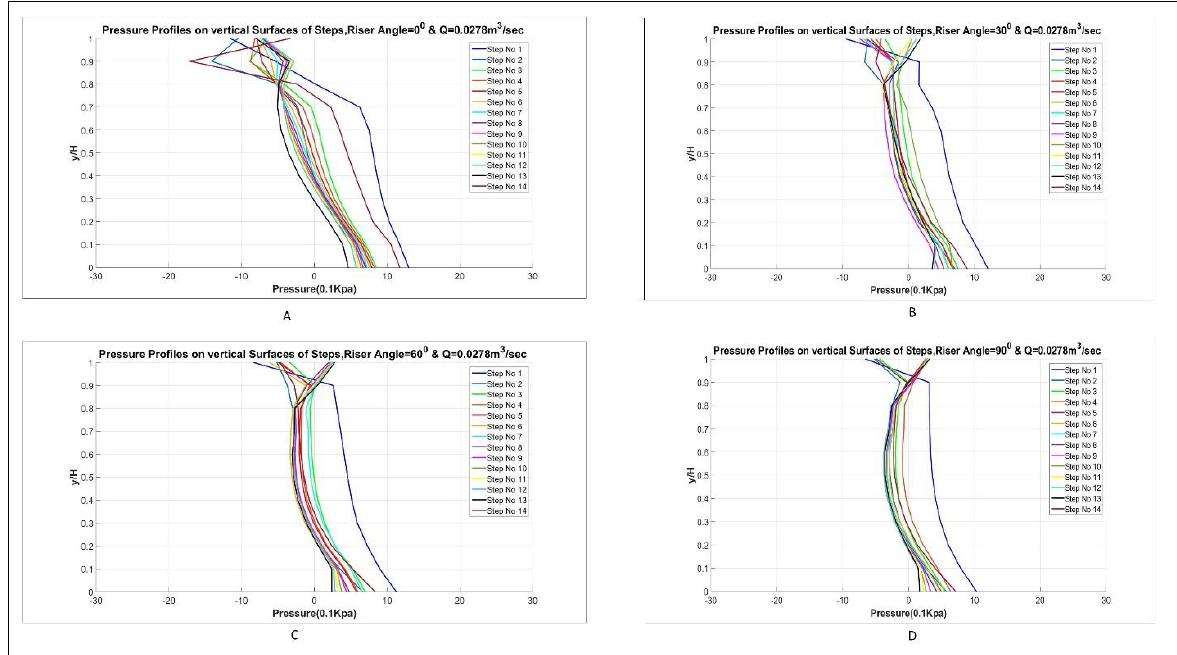
Figure 9. Pressure profiles for ( A ) simple stepped, ( B ) 30°, ( C ) 60°, and ( D ) 90° curved risers spillway for the head of 100 mm.